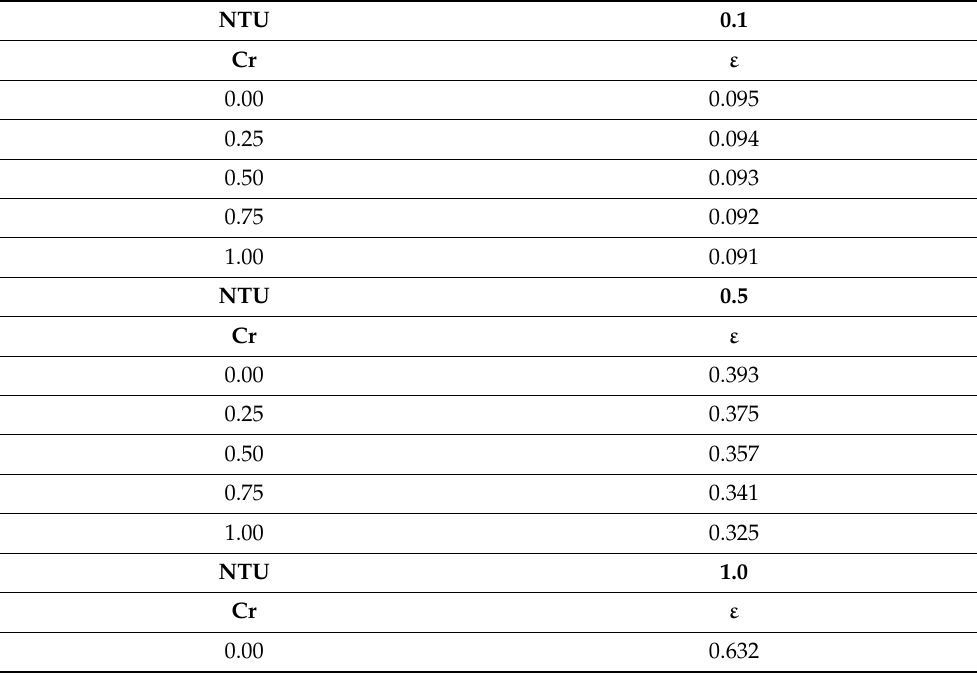
Figure 5. Performance predictions of a 3-row pure cross flow heat exchanger undergoing sensible heat transfer. Table 1. Performance predictions of a 1-row pure cross flow heat exchanger in terms of dimensionless parameters. C min — External Fluid C max — Internal Fluid; sensible heat transfer